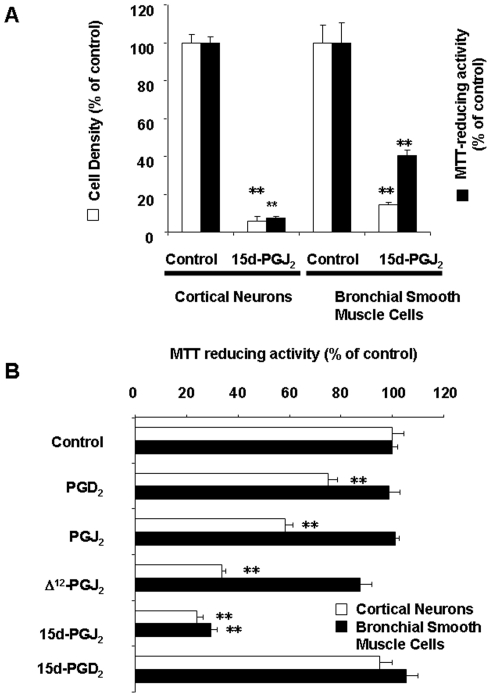
15d-PGJ2 downregulated cortical neurons and BSMC.(A) Cortical neurons and BSMC were treated with vehicle (control) or 10 µM 15d-PGJ2. Vehicle was 0.1% ethanol. Cell densities (open columns) and MTT-reducing activities (closed columns) in cortical neurons and BSMC were determined 24 h or 48 h later, respectively. (B) Cortical neurons and BSMC were treated with vehicle (control), PGD2, PGJ2, Δ12-PGJ2 or 15d-PGJ2 at 10 µM. Vehicle was 0.1% ethanol. MTT-reducing activities in cortical neurons (open columns) and BSMC (closed columns) were determined 8 h or 48 h later, respectively. Data are expressed as means ± S.E.M. (n = 4). **P<0.01, compared with control by ANOVA followed by Dunnett's test.